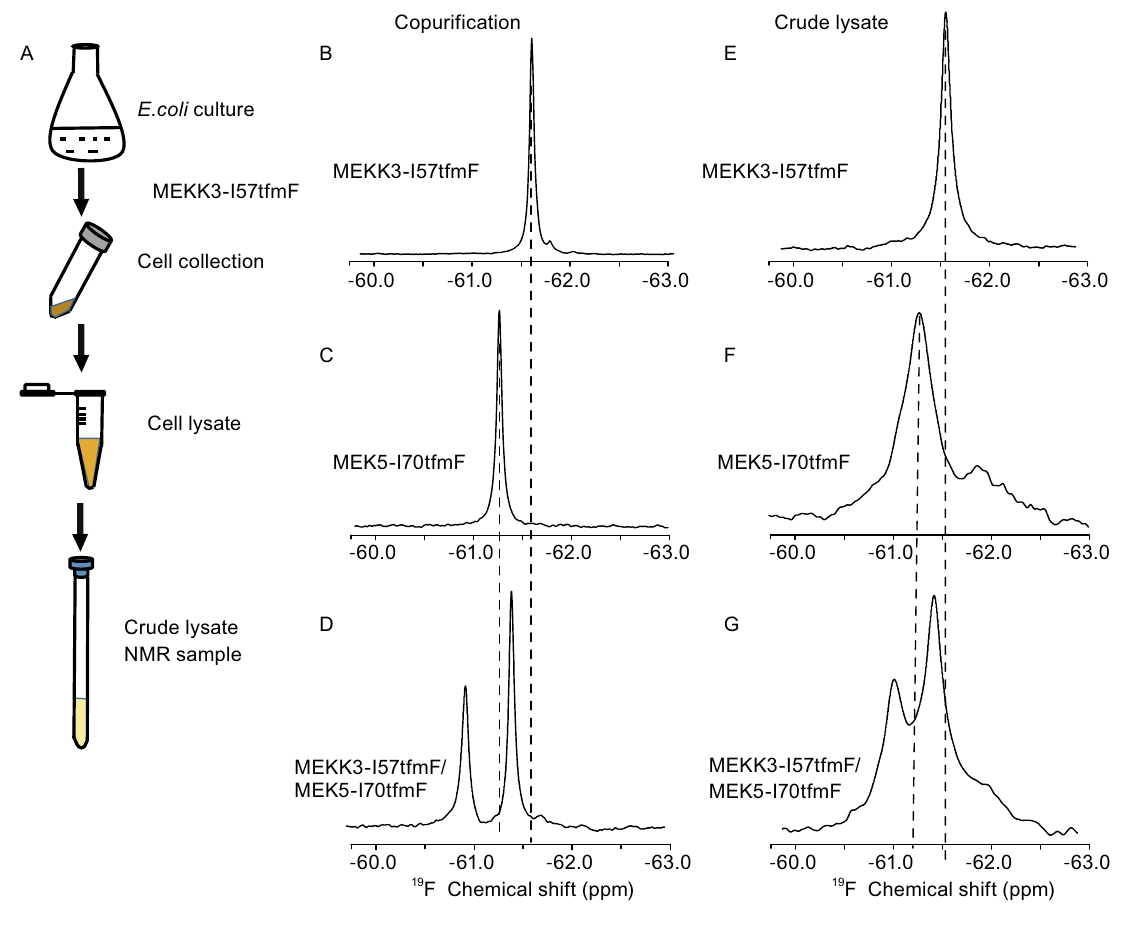
Figure 2. One dimensional 19 F NMR spectra of MEKK3-PB1 or MEK5-PB1 in crude lysates with double site-speci fi c tfmF incorporation . Procedure of crude lysate sample preparation (A), One-dimension 19 F spectra of puri fi ed MEKK3-PB1-I57tfmF (B), MEK5-PB1-I70tfmF (C), and co-expressed MEKK3-PB1-I57tfmF and MEK5-PB1-I70tfmF complex (D). One-dimension 19 F spectra